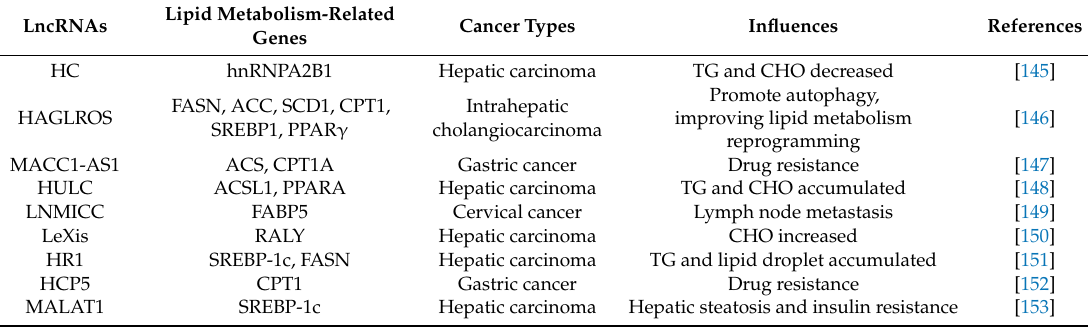
Table 2. Long-chain non-coding RNAs (lncRNAs) related to lipid metabolism in cancer.